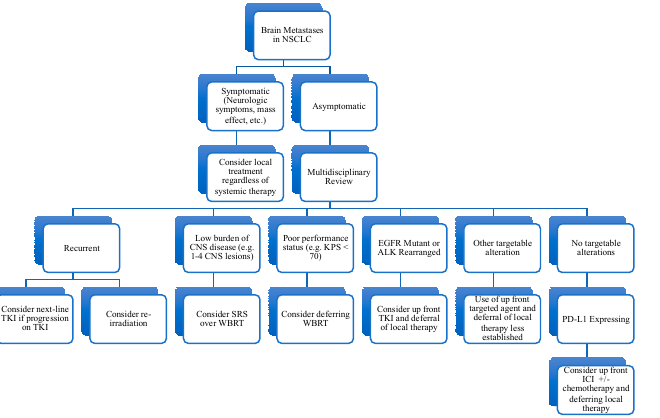
Figure 1. Decision tree for management of brain metastases in non-small cell lung cancer. Abbreviations: non-small cell lung cancer (NSCLC); central nervous system (CNS); Karnofsky Performance Status (KPS); tyrosine kinase inhibitor (TKI); stereotactic radiosurgery (SRS); whole brain radiotherapy (WBRT); immune checkpoint inhibitor (ICI).